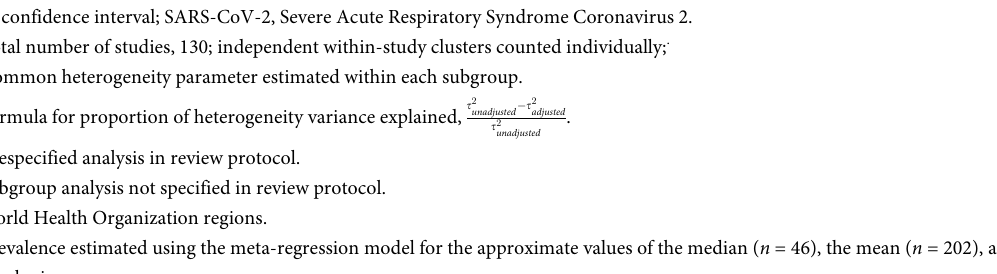
d Prespecified analysis in review protocol. e Subgroup analysis not specified in review protocol. f World Health Organization regions.